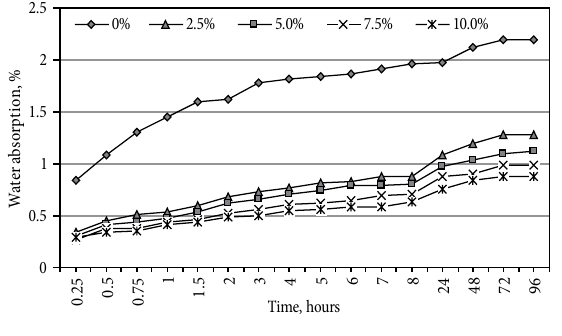
Fig. 5. Kinetics of water absorption